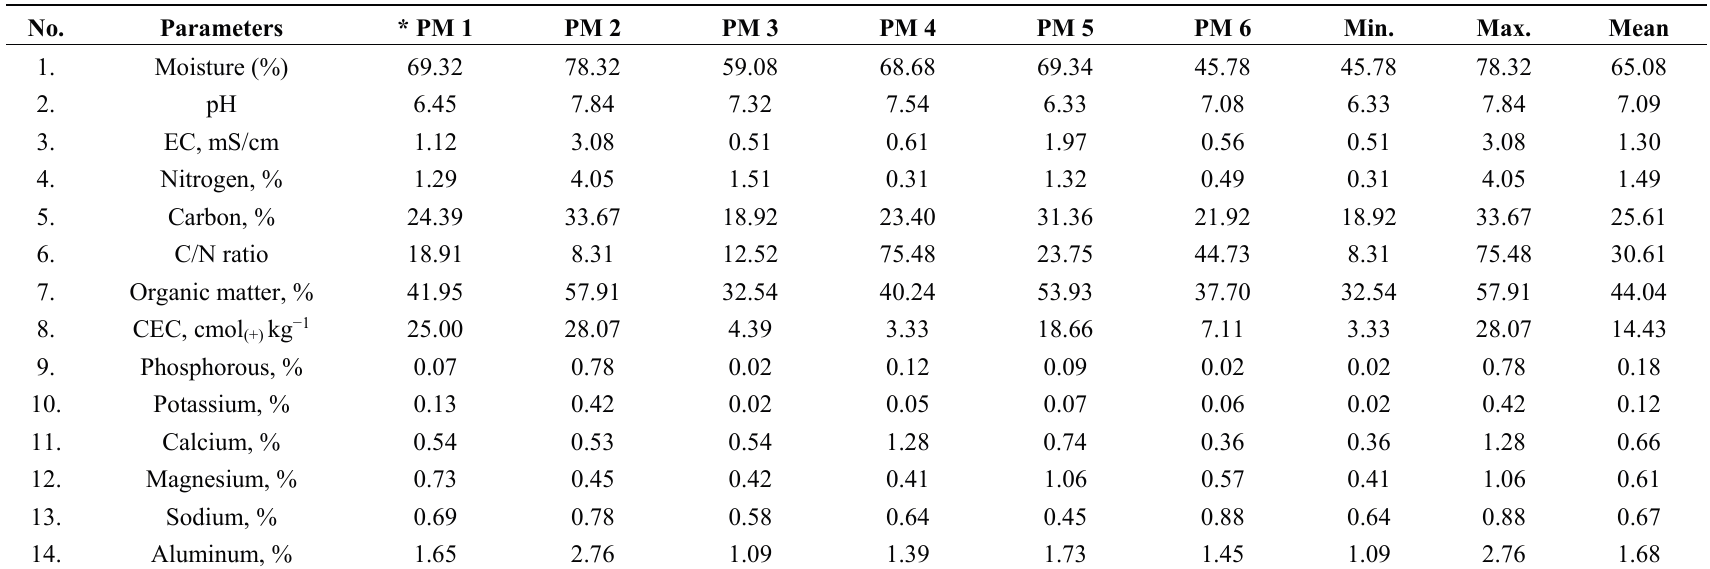
Table 1. Physico-chemical characteristics of paper mill sludges from different paper mill industry sites.